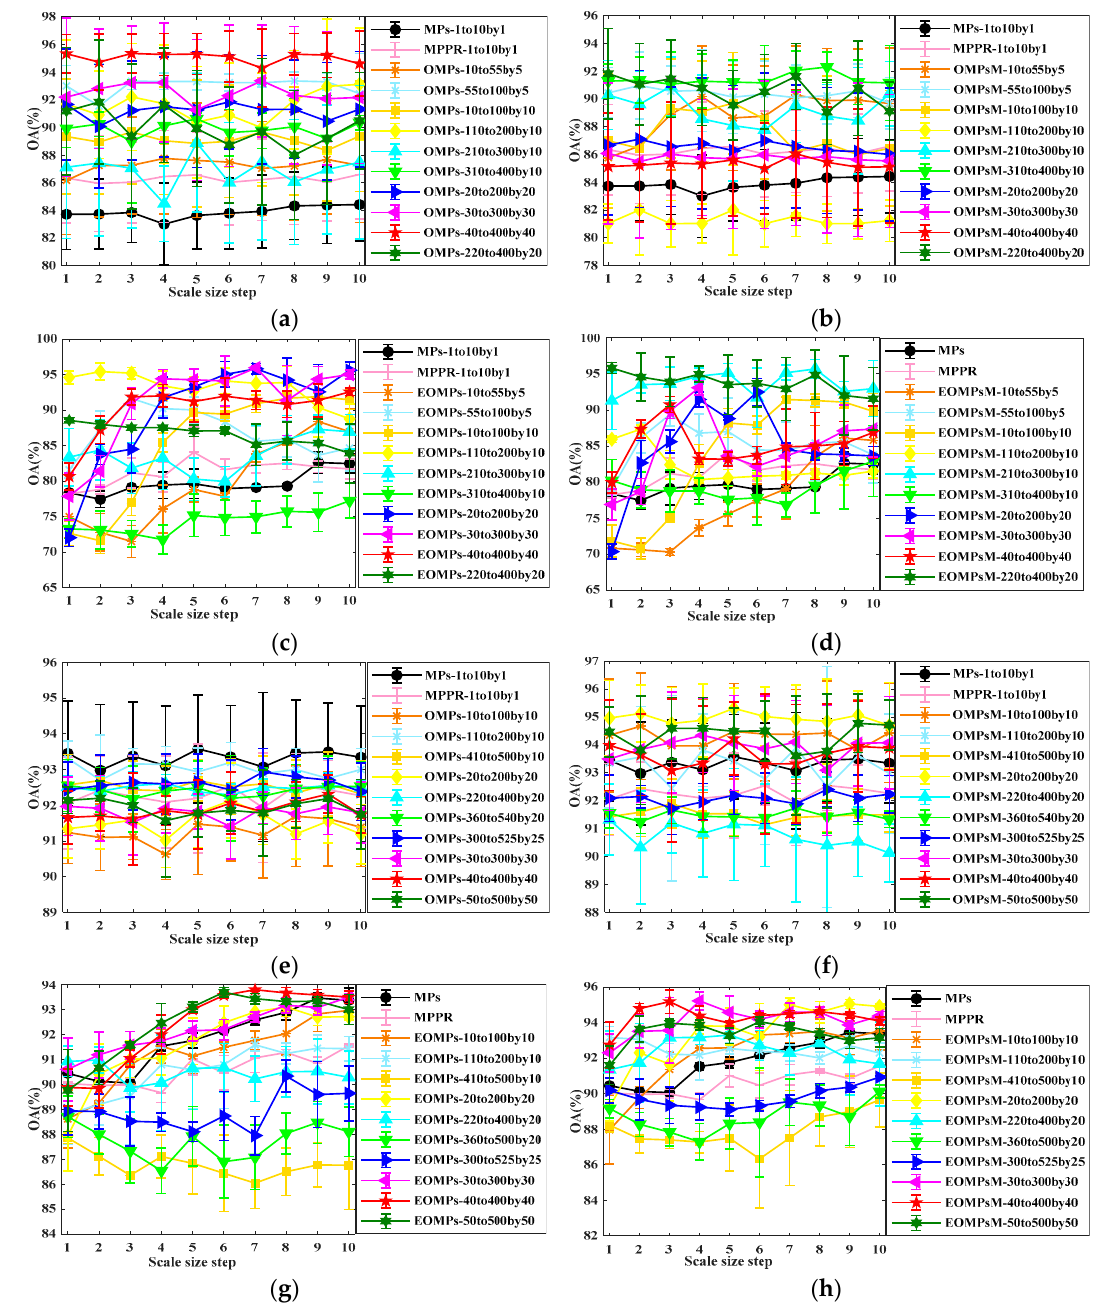
Figure 4. Mean overall accuracy (OA) values versus different sizes of structural elements (SEs) and segmentation scale sets in morphological profiles (MPs), morphological profiles with partial reconstruction (MPPR), extended object ‐ guided morphological profiles (EOMPs) and EOMPs with mean values (EOMPsM) on raw spectral ( a , b , e , f ) and principal component analysis (PCA)-transformed ( c , d , g , h ) features from Reflective Optics System Imaging Spectrometer (ROSIS) university (row 1) and GRSS-DFC2013 (row 2) data sets using an support vector machine